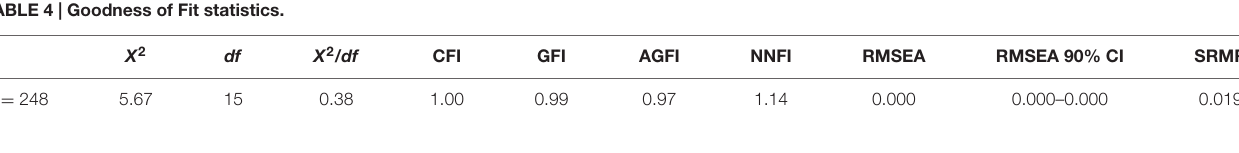
TABLE 4 | Goodness of Fit